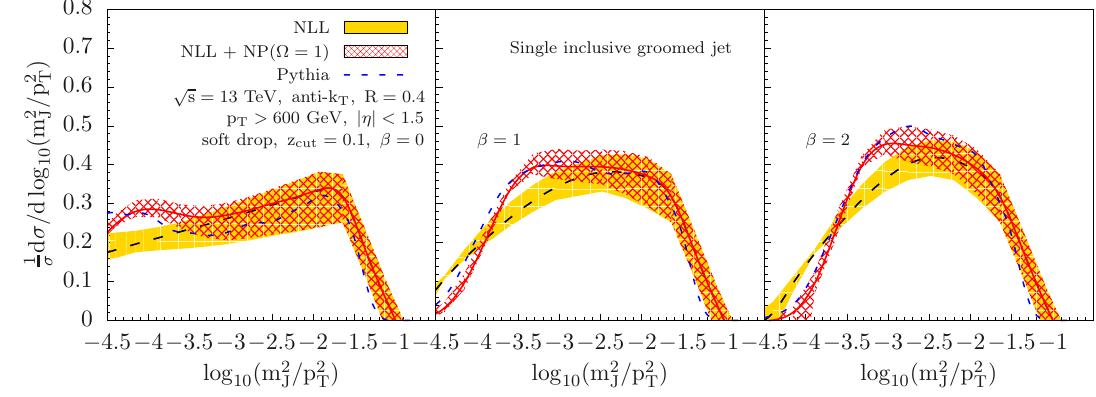
Figure 7 . Same as for (cid:12)gure 6, but for jets with R = 0 : 4. The parameter of the non-perturbative shape function is chosen as (cid:10) = 1 GeV, to agree better with the Pythia8